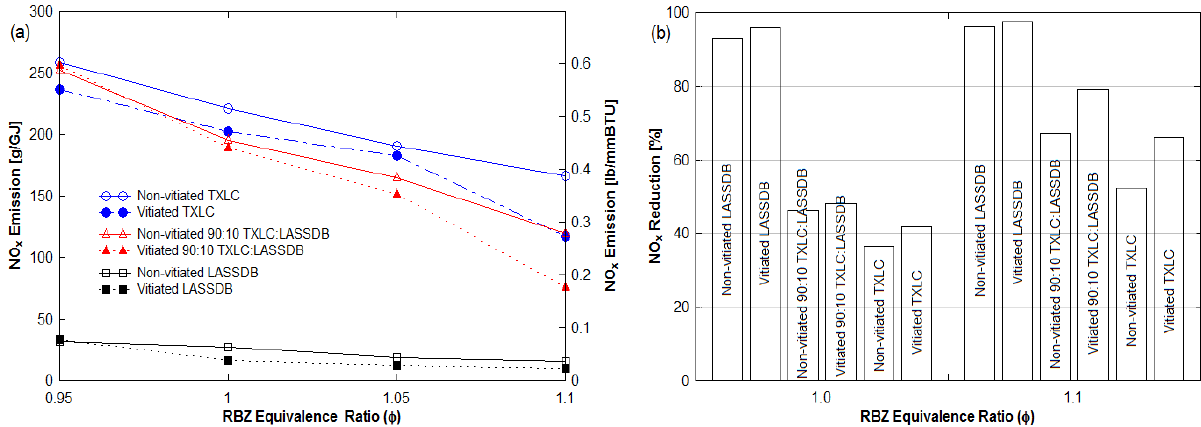
Figure 10. Effect of the vitiated reburn air (30% reburn heat input and 0° reburn injection): ( a ) NO x emission and ( b ) NO x reduction on a heat basis.